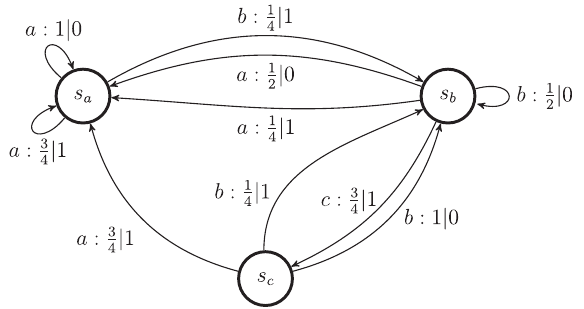
FIG. 4. Nontightness of fidelity bound. Hidden Markov model representation of a counterexample strategy to the tightness of the fidelity bound, as described in Appendix